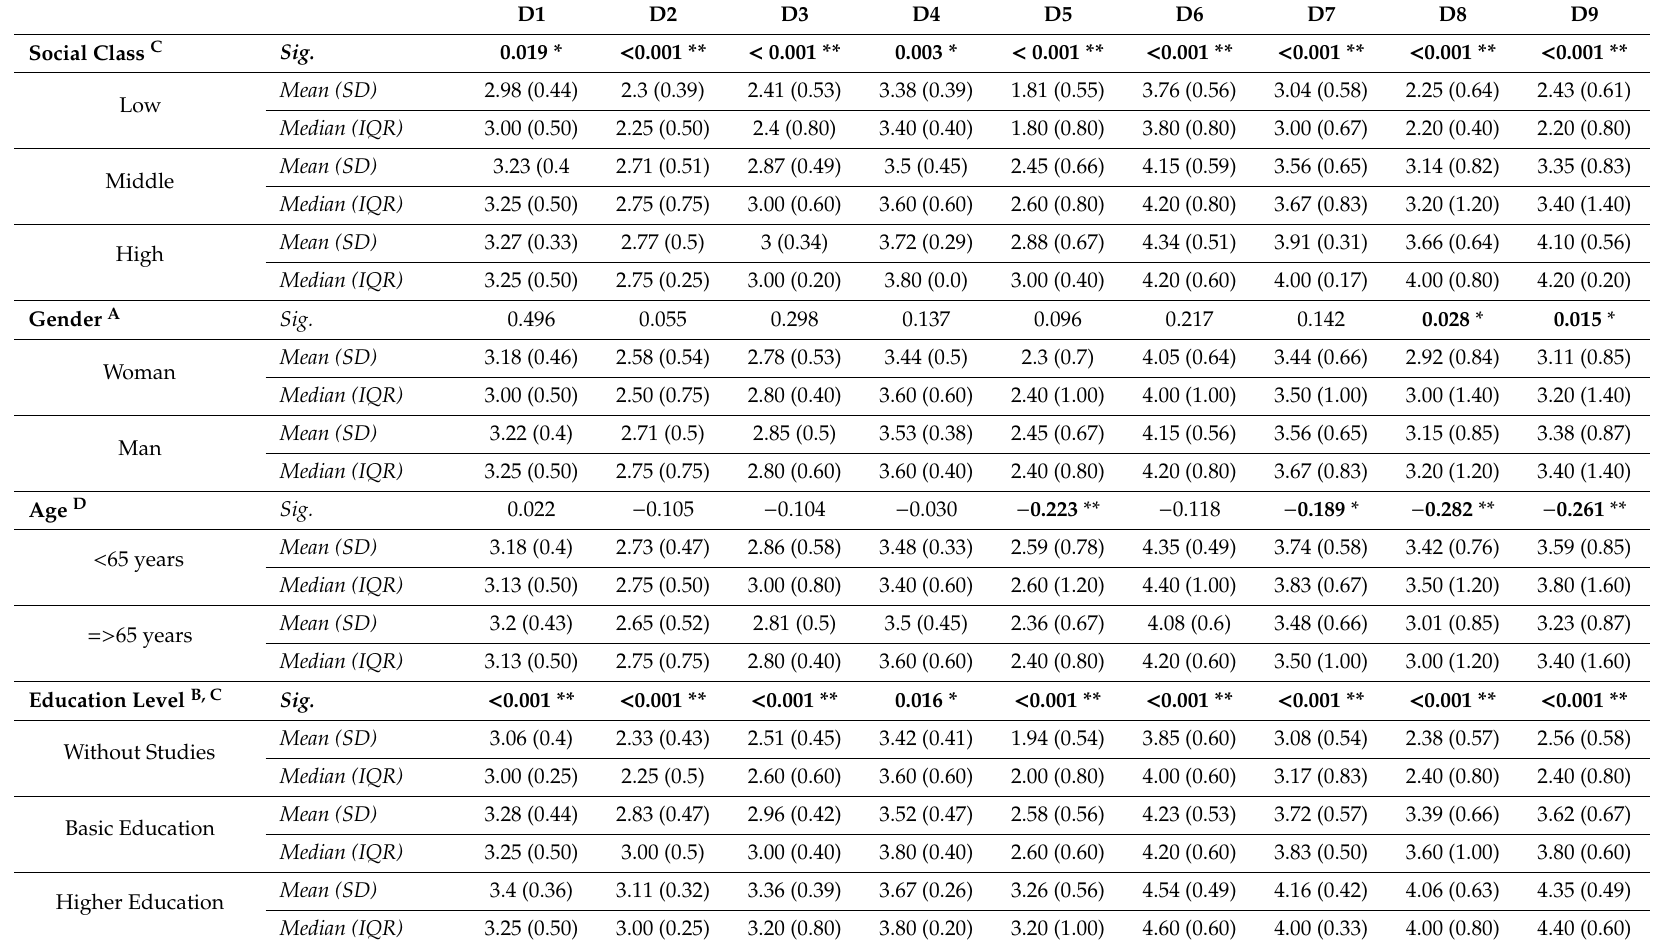
Table 3. Relationship and statistical significance between variables and HL